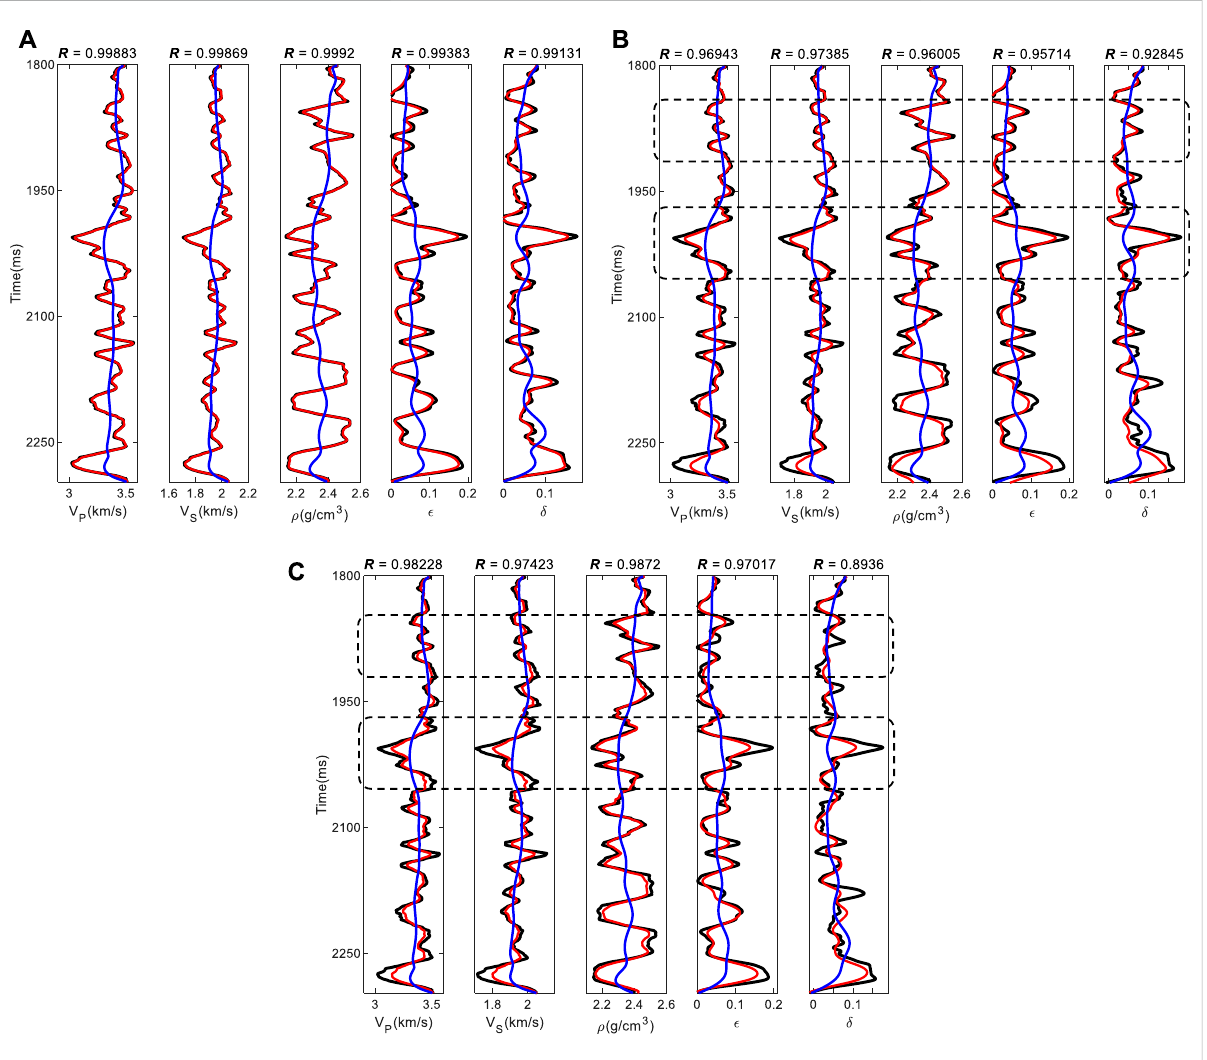
FIGURE 6 Inversion results. (A) Cauchy constraint inversion in noiseless trace gather; (B) Cauchy constraint inversion in SNR = 2 trace gather; (C) Nonconstraint inversion in SNR = 2 trace gather. The black line indicates the true data, the red line indicates the inversion result, and the blue line indicates the initial data. The accuracy of (A) is the highest, the accuracy of (B) is acceptable, and the accuracy of (C) is poor. (A) Shows the feasibility of theinversion algorithm. By comparing (B) and (C) (particularly in the vicinity of black dashed boxes), it can be seen that using theconstrained inversion method to process noisy data can increase the accuracy and stability of